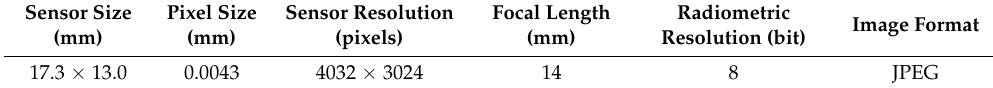
Table 2. Technical specifications of the imaging sensor on board the Unmanned Aerial Vehicle (UAV).